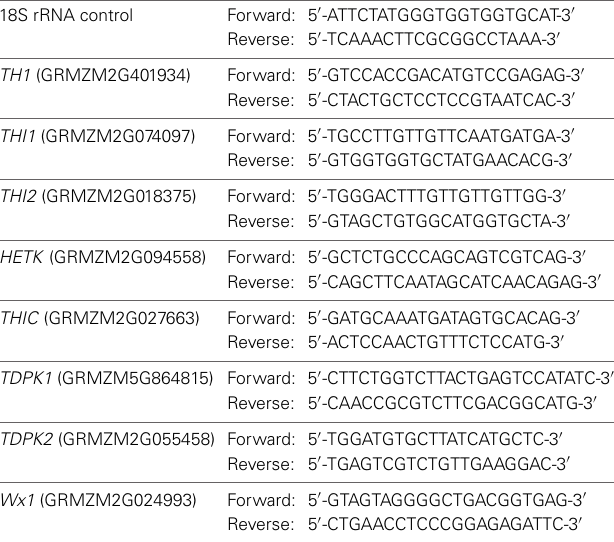
Table 2 | Gene specific primers for